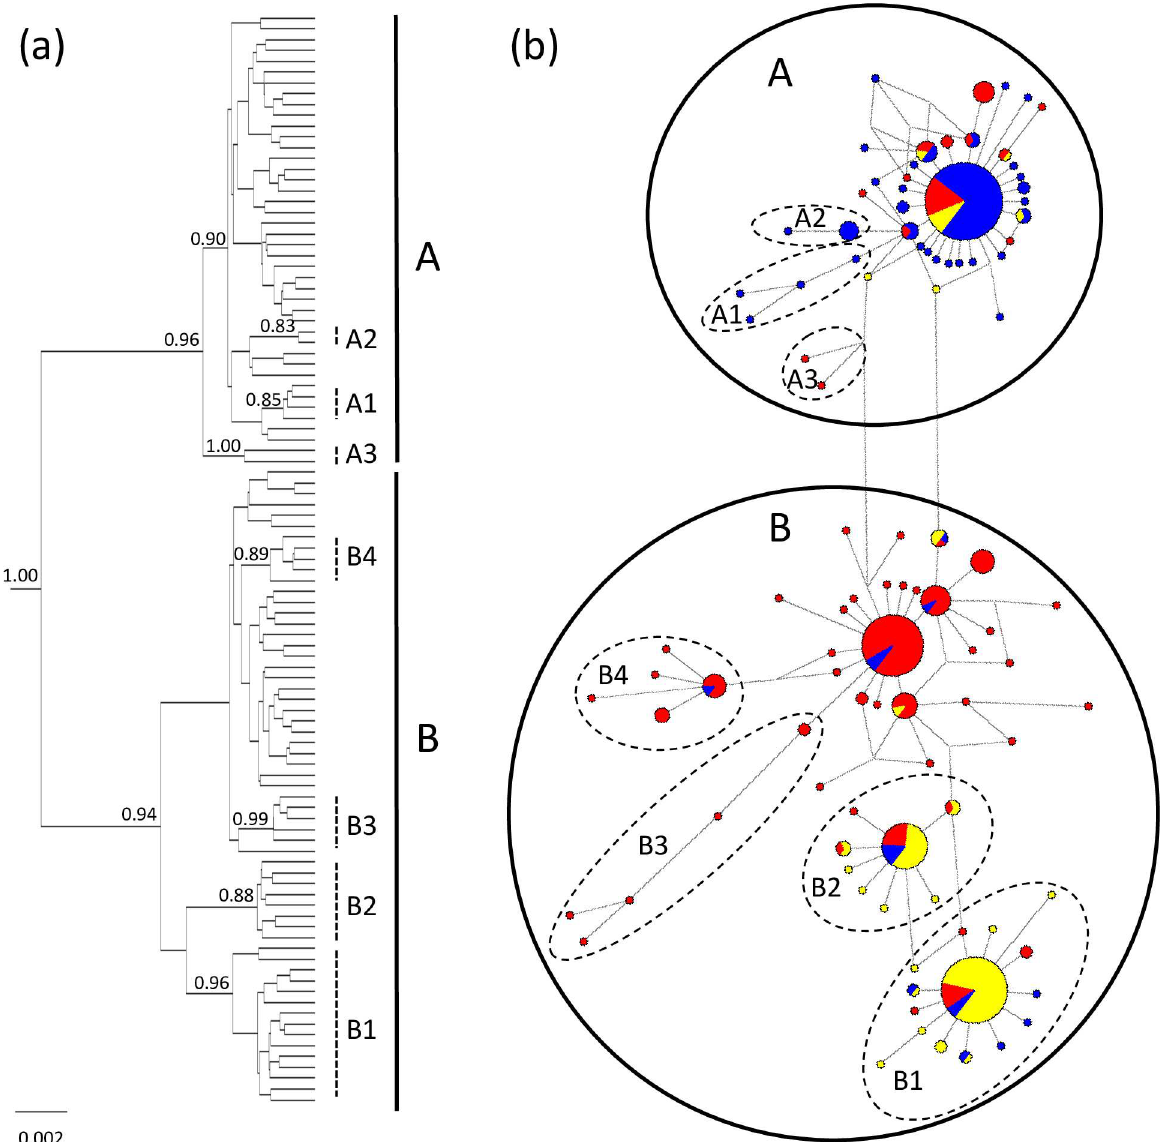
Fig 2. Bayesianconsensus tree (a) and network (b) for European Ixodes ricinus . The estimates are basedon 763 bp of concatenated cyt b and the control regionof mtDNA. Bayesian posterior probabilities > 0.80 providedat the tree-nodes. Cladelabels used throughout the text are indicatedas vertical bars besidethe tree and as encircledhaplotypes in the network. The proportional occurrence of each haplotypein the materialis illustratedby the size of the pie diagrams, which have colored pies accordingto the geographicaldistribution of the haplotypes amongthe three main areas of the study: blue = Great Britain, yellow = western Norwayand red = continental Europe. (Not the difference in the meaningof the color codes in Figs 1 and 2).